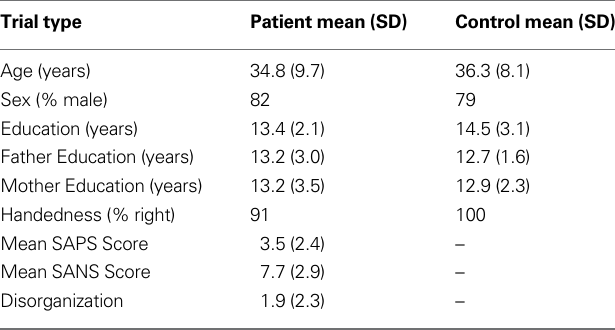
Table 1 | Clinical and demographic